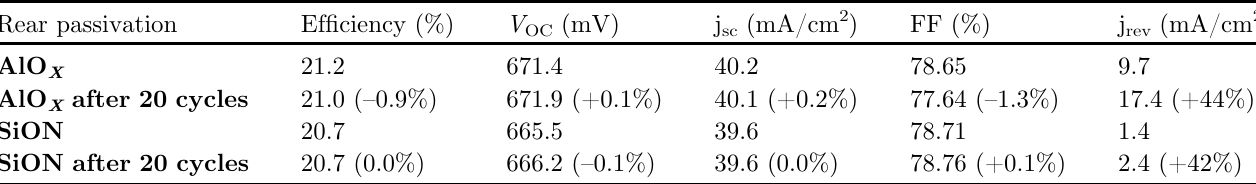
Table 1. Selected cell parameter results at the 1st and 20th measurement cycle of HIP-MWT+ with different passivation stacks. The relative changes between 1st and 20th measurement are indicated in